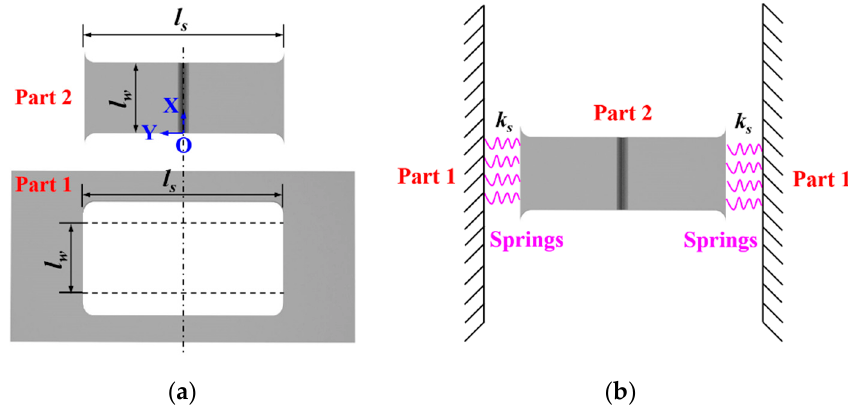
Figure 2. Schematic illustration of the self-restrained mechanism of the H-type slit specimen: ( a ) Combination of the H-type slit joint; ( b ) joint restrained by a set of springs.